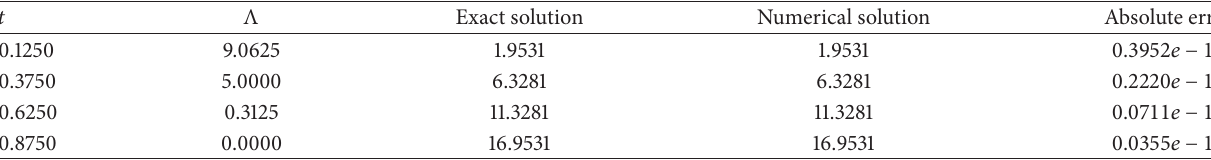
Table 1: Computational results of Example 1 for 𝑅 = 1 and 𝑛 = 3 .